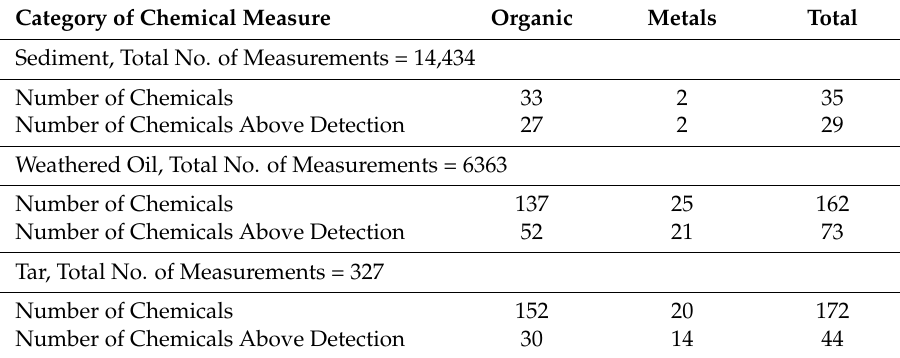
Table 1. Number of chemical measures in sediments, weathered oil, and tar collected by the EPA during and immediately after the DWH oil spill